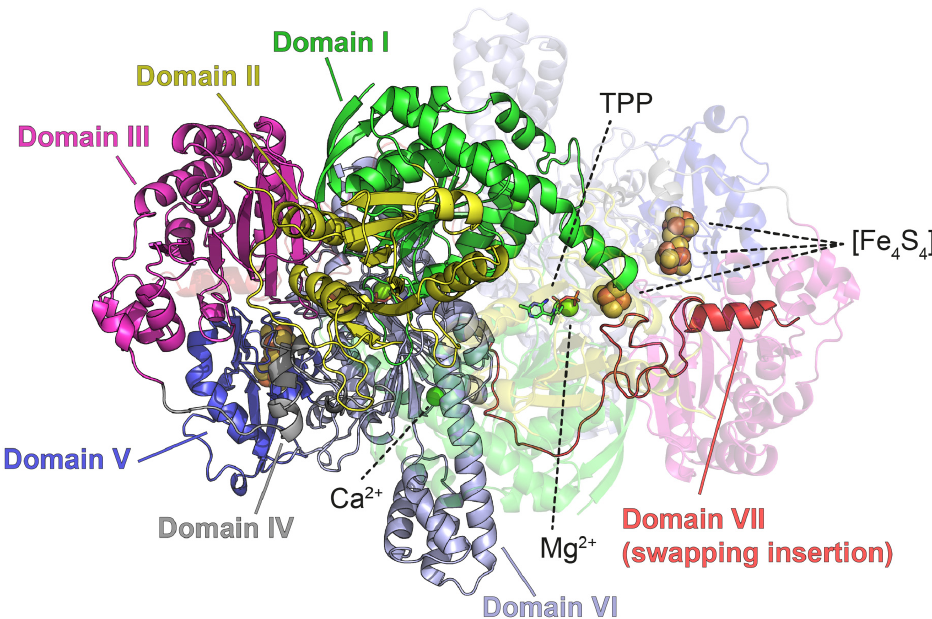
Figure 1. Crystal structure of PFOR (PDB code: 1B0P). The seven structural domains are colored differently as previously defined [26]: Domain I (residues 1–258), green; Domain II (residues 259–415), yellow; Domain III (residues 416–627), pink; Domain IV (residues 628–668), gray; Domain V (residues 669–785), blue; Domain VI (residues 786–1170), light blue; Domain VII (residues 1171–1232), red. TPP molecules are displayed in sticks; [Fe 4 S 4 ], Mg 2+ and Ca 2+ are displayed with spheres. One of the monomers is displayed as a transparent image.